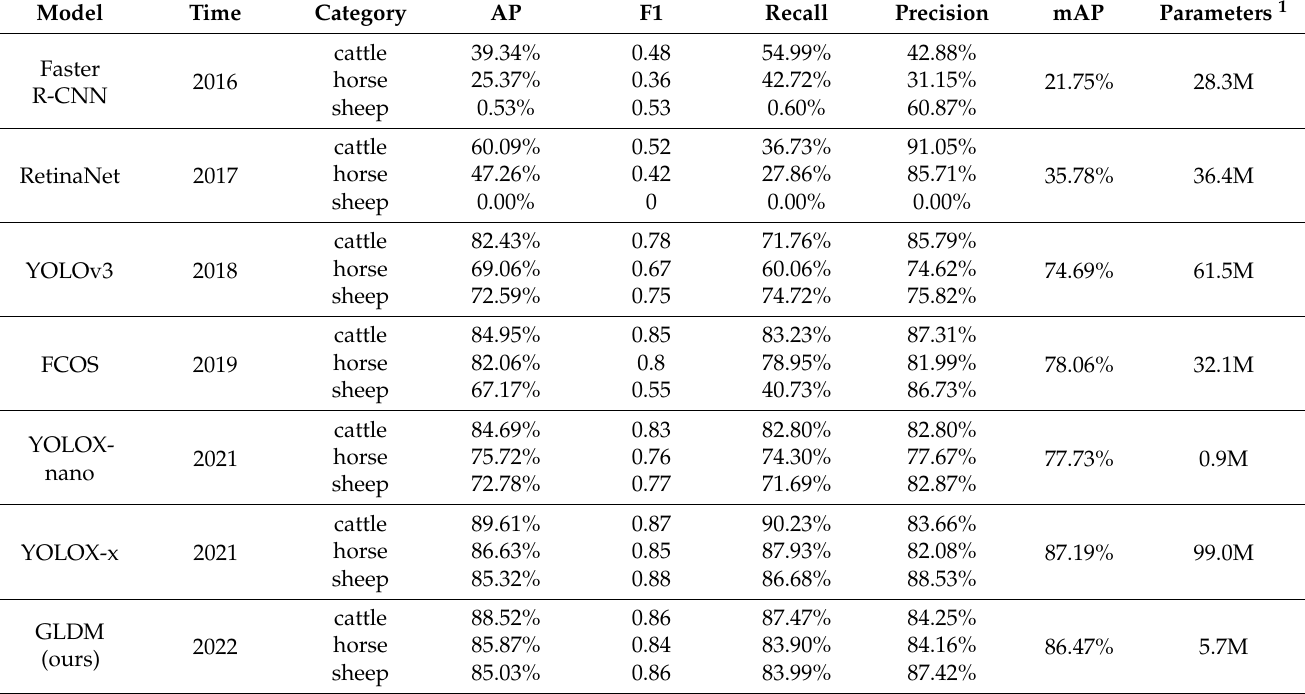
Table 4. Comparison of state-of-the-art object-detection